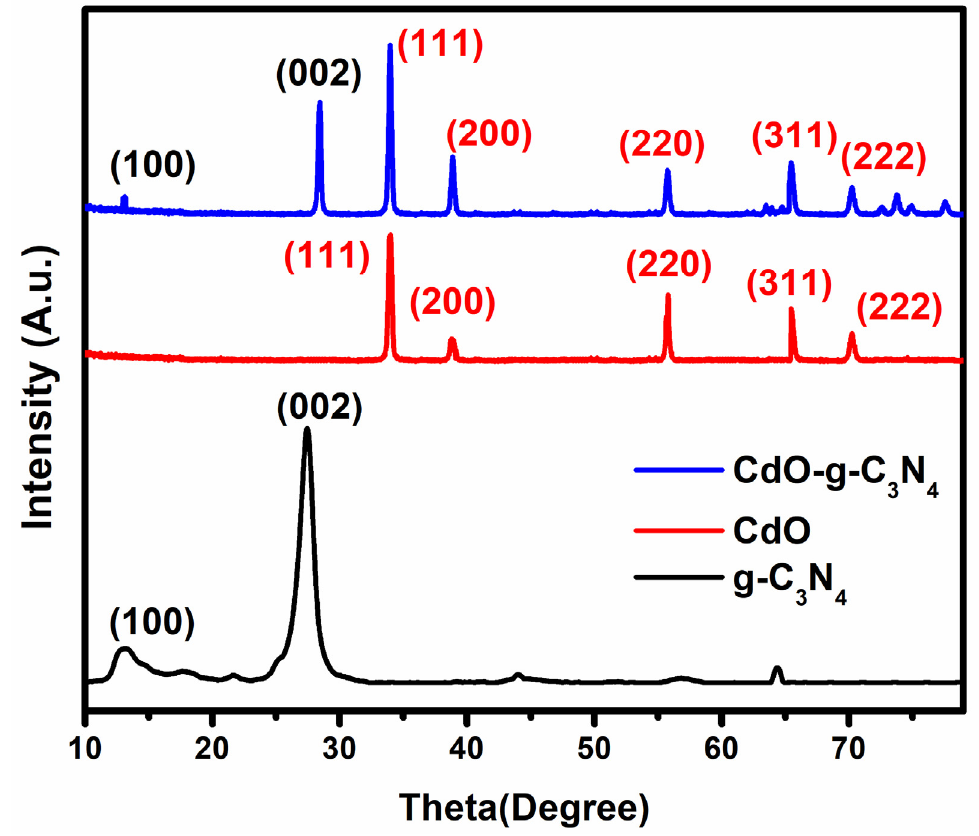
Figure 1. The XRD patterns of g-C 3 N 4 , CdO , and CdO–g-C 3 N 4 nanomaterials.